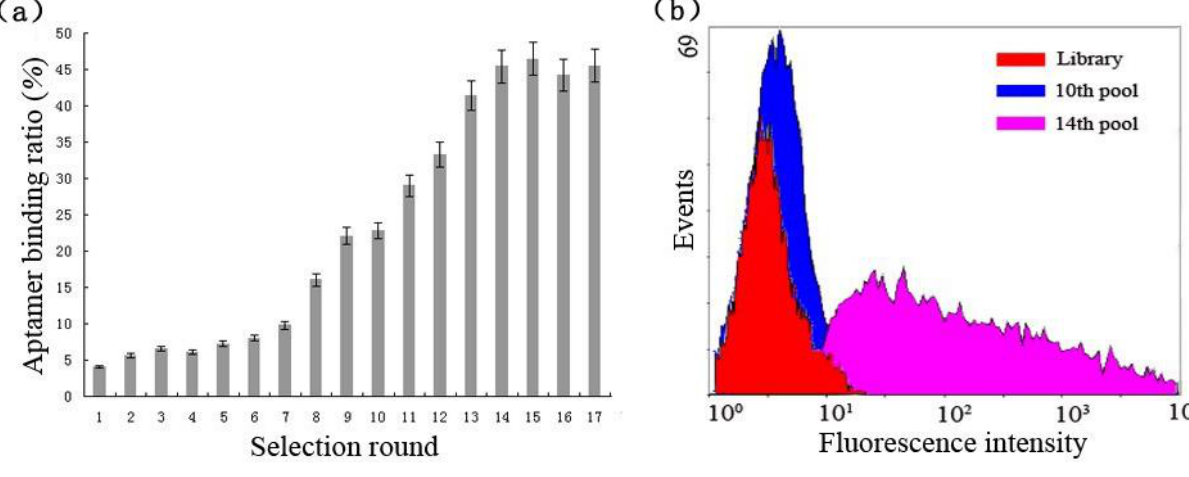
Figure 2. Enrichment of S. Paratyphi A-specific aptamers during the whole-cell SELEX procedure. ( a ) The bar graph reveals the ratio of the amounts of ssDNA eluted to the amounts of ssDNA pool in this round selection. Error bars indicate standard deviation (n = 3). ( b ) Flow cytometry assay to monitor the pool enrichment for S . Paratyphi